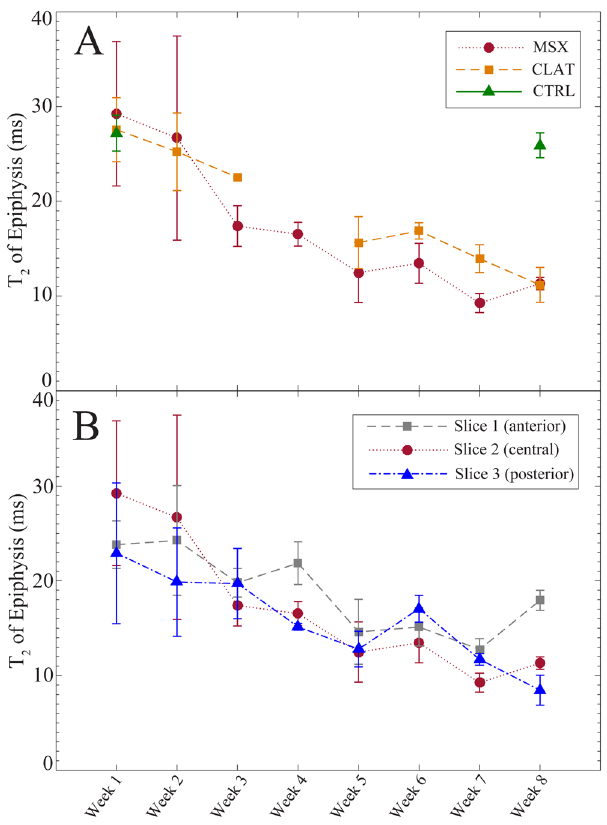
Figure 5. Mean T 2 of medial epiphysis of CTRL, MSX and CLAT joints over the eight week observation period post meniscectomy ( A ). The data represent epiphyseal T 2 measured from central coronal slice location. The epiphyseal T 2 of medial condyles of anterior (slice 1), central (slice 2) and posterior slice (slice 3) locations for the MSX joints are shown in ( B ). Data plotted as mean ± SE.